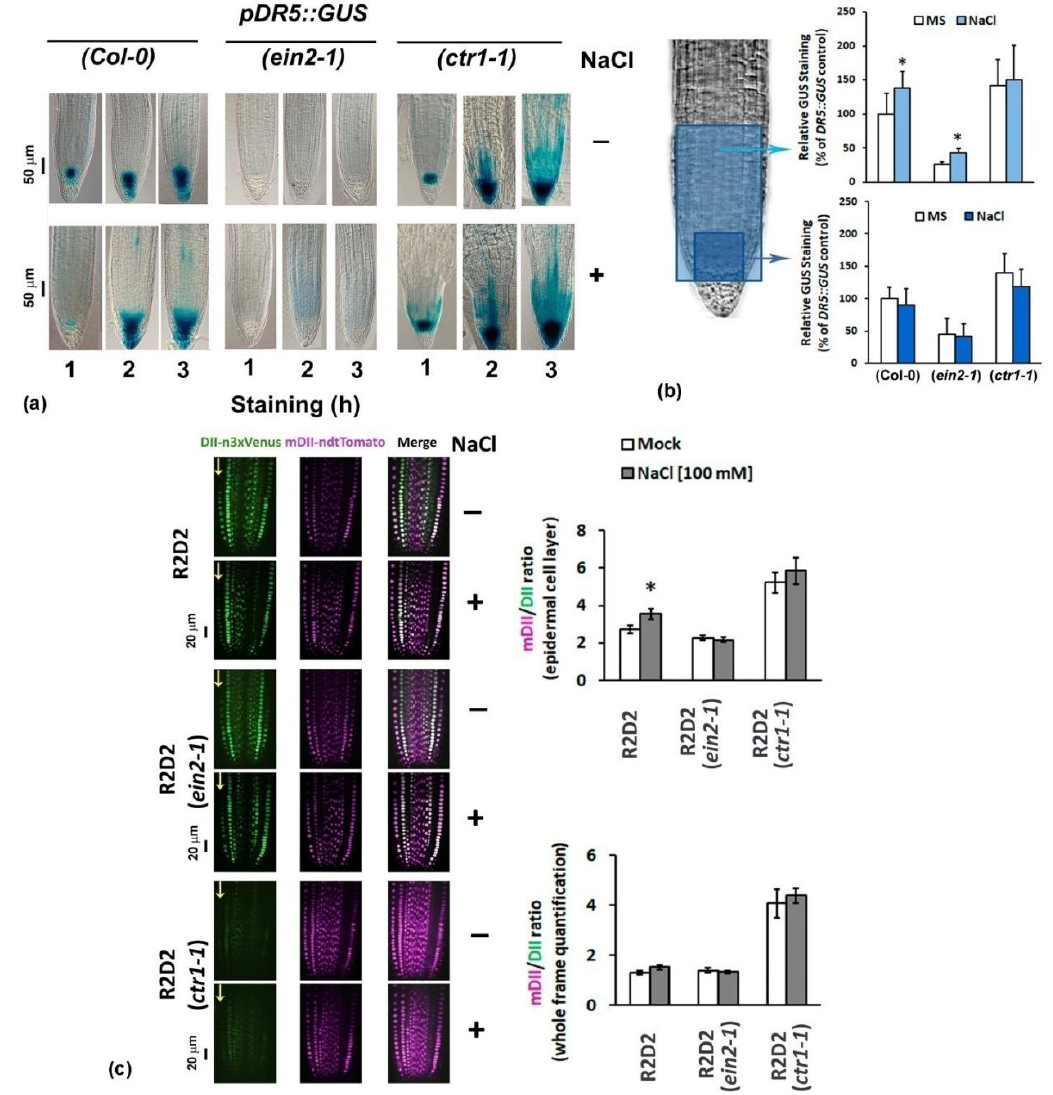
Figure 2. ( a ) Representative images of pDR5::GUS patterns in six-day-old control and 100 mM NaCl-treated (48 h) individuals with wild type Col-0, and ein2-1 and ctr1-1 mutant backgrounds (homozygous F3 plants), incubated for 1, 2 or 3 h in β -Glucuronidase (GUS) staining solution. ( b ) Whole frame and root meristem GUS intensity measured in 2 h-stained plants (Col-0, ein2-1 and ctr1-1 ). Results are represented as percentage of the untreated control reporter. Asterisks depict statistically significant difference within the genotype (treated vs. non-treated), one-way ANOVA, p ≤ 0.05, n ≥ 3 datasets from independent crosses. (c) Fluorescent signal evaluation (whole frame and epidermis) in roots of control and 100 mM NaCl-treated (48 h) R2D2 plants and their homozygous F3 crosses with ctr1-1 and ein2-1 . Arrows mark the epidermal cell file. Asterisk depicts statistically significant difference within the genotype (treated vs. nontreated), n ≥ 10 individuals from one homozygous F3 line were